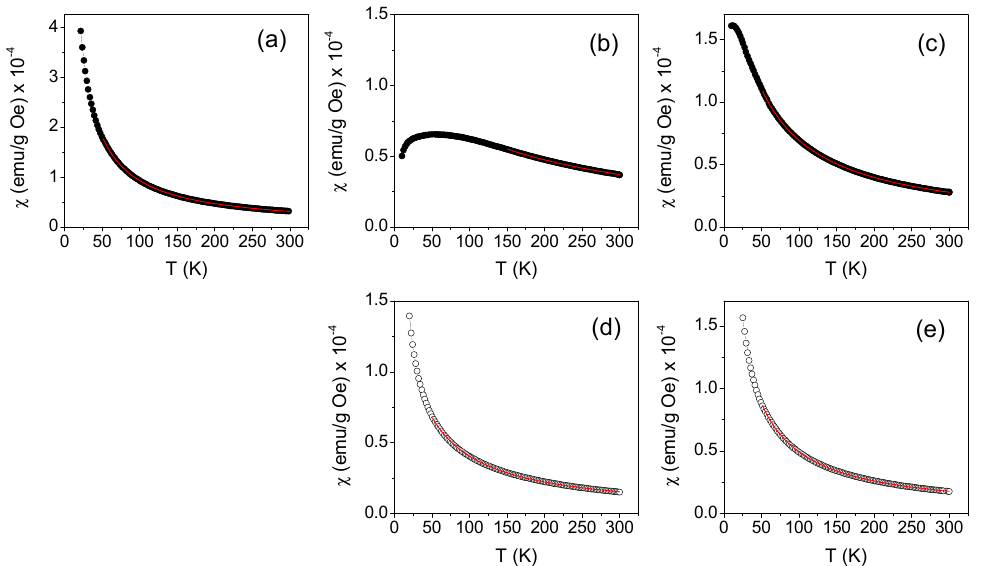
Figure 3. Curves of mass susceptibility ( χ ) as a function of temperature (T) measured on the freshly ( a – c ) or aged ( d , e ) prepared MP ( a ), MDE2 ( b , d ), and MDB ( c , e ) compounds, in H appl = 10 kOe. The red lines are the fitting curves to the Curie–Weiss law.